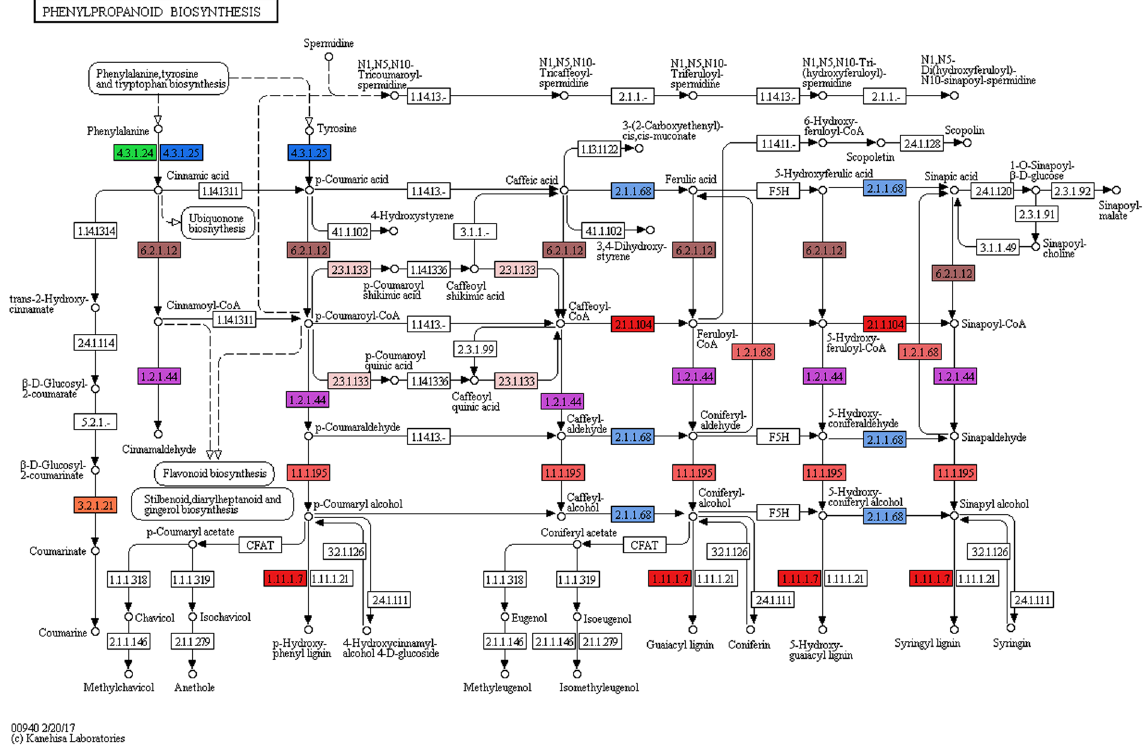
Figure 5. Phenylpropanoid biosynthesis pathway from Solanum trilobatum by KEGG analysis showing the different identified enzymes (one color for each Enzyme Code or EC). KEGG pathway map 00940 is adapted here from http://www.kegg.jp/kegg/kegg1.html. The KEGG database has been described previously 60–62